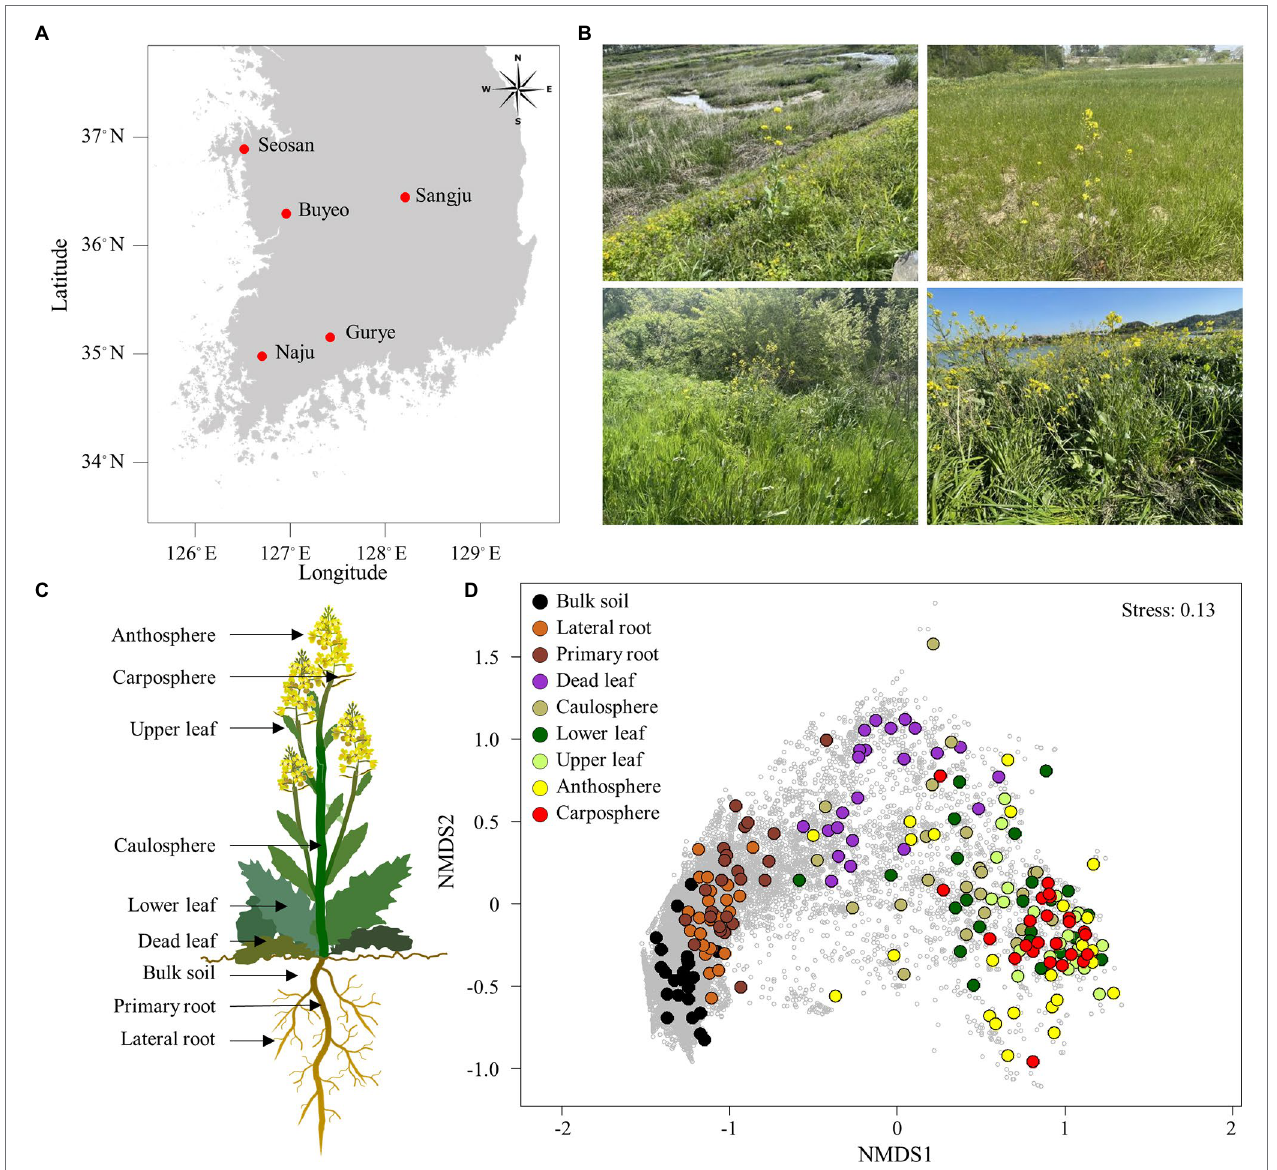
FIGURE 1 | Sampling area and holobiont of Brassica napus . (A) Map showing the sampling sites. (B) Sampling sites with B. napus . (C) Holobiont samples collected in this study. (D) Non-metric multidimensional scaling (NMDS) ordination plot of Bray–Curtis community dissimilarities based on prokaryotic ASVs. Small gray circles represent